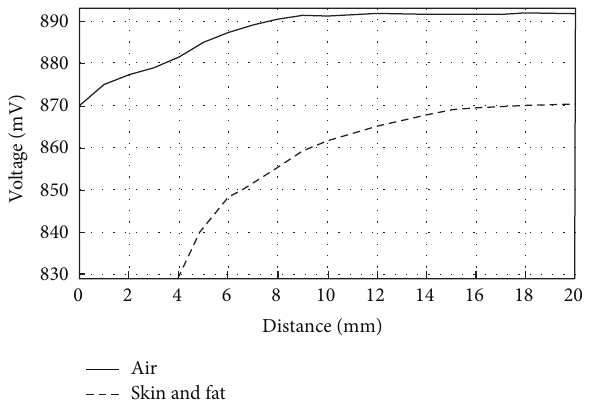
Figure 13: Voltage variations on reader coil versus distance. Trans- mission medium between coils: 1mm of pork skin and 1mm of fat.